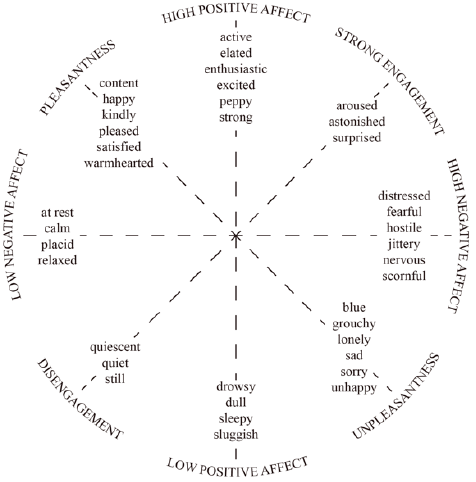
Figure 3. Tellegen-Watson-Clark model. In the model, high positive affect and high negative affect are proposed as two independent dimensions, whereas pleasantness–unpleasantness and engagement-disengagement represent the endpoints of one bipolar dimension.